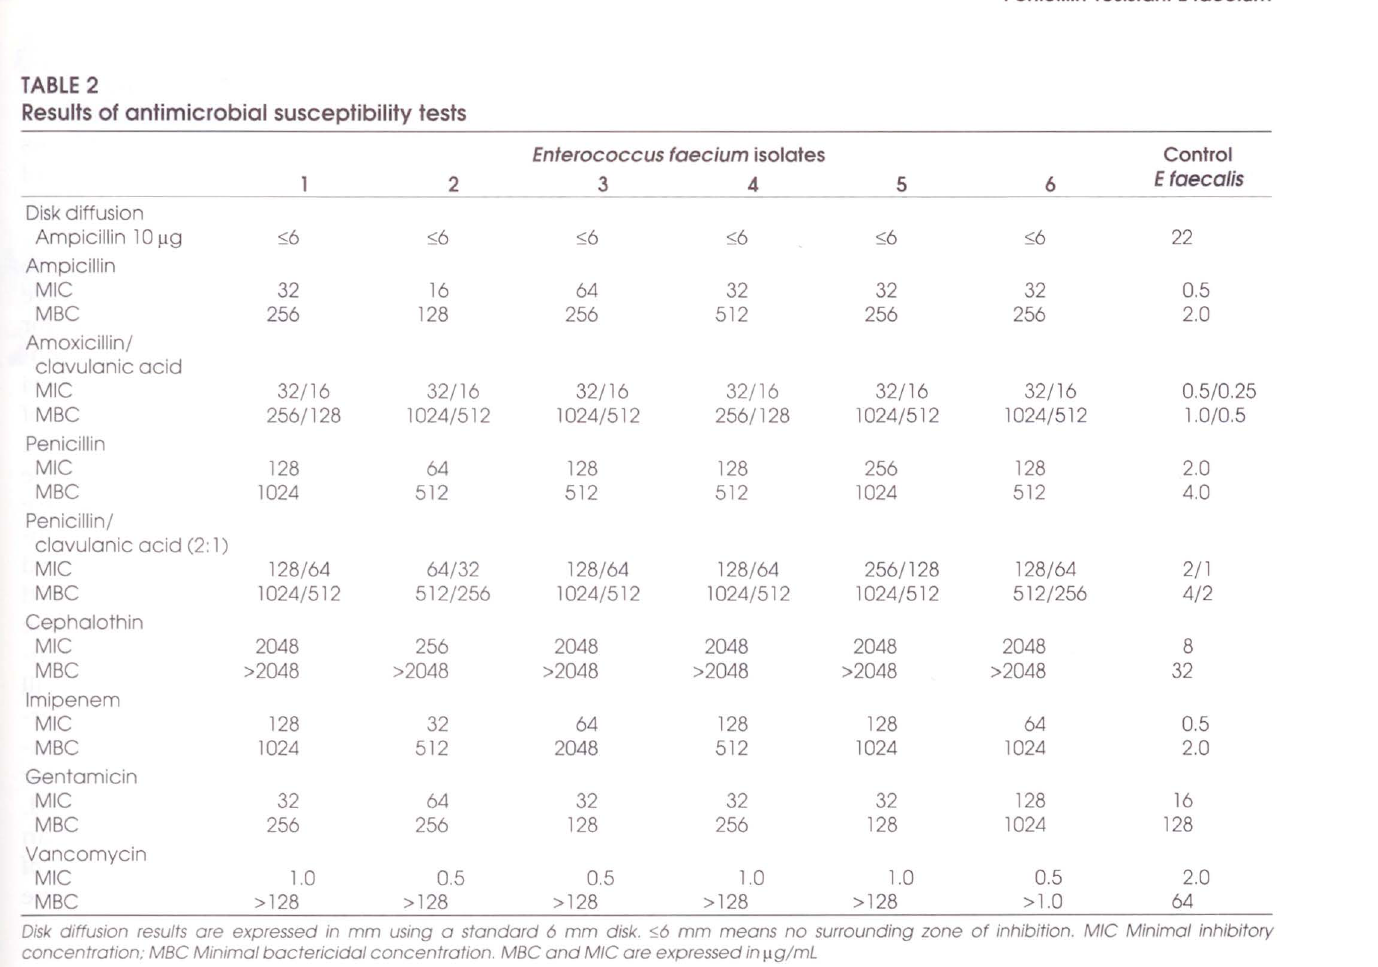
TABLE 2 Results of antimicrobial susceptibility tests